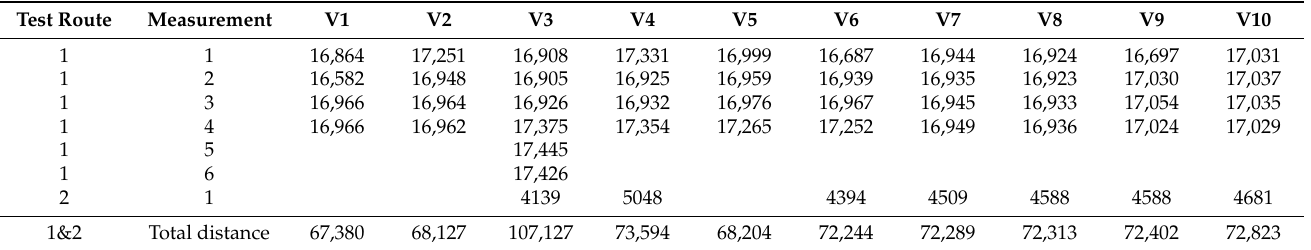
Table 4. Distances in meters travelled according to vehicles, measurements, and test routes calculated from GPS